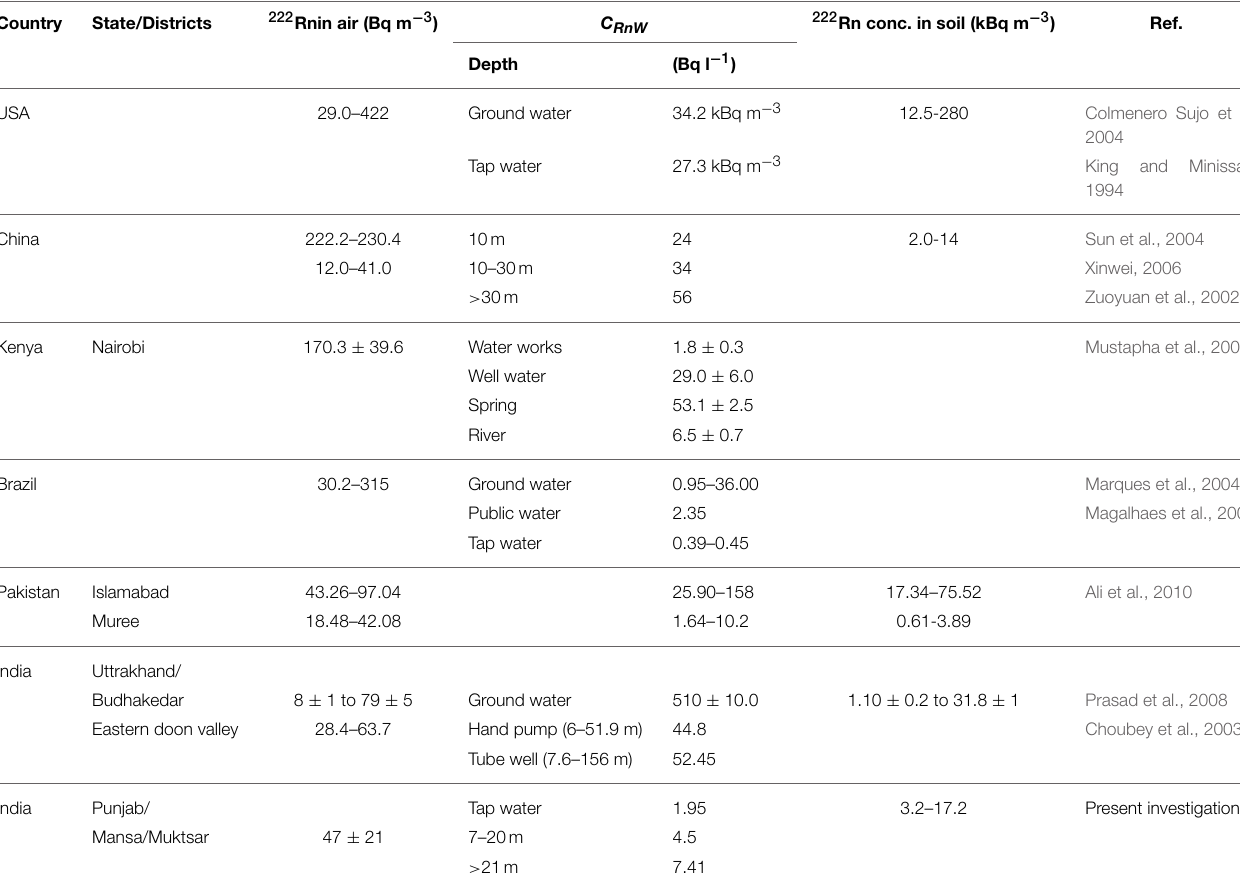
TABLE 2 | The comparison of mean 222 Rn concentrations in indoor air, water, and soil gas samples from different countries. Country